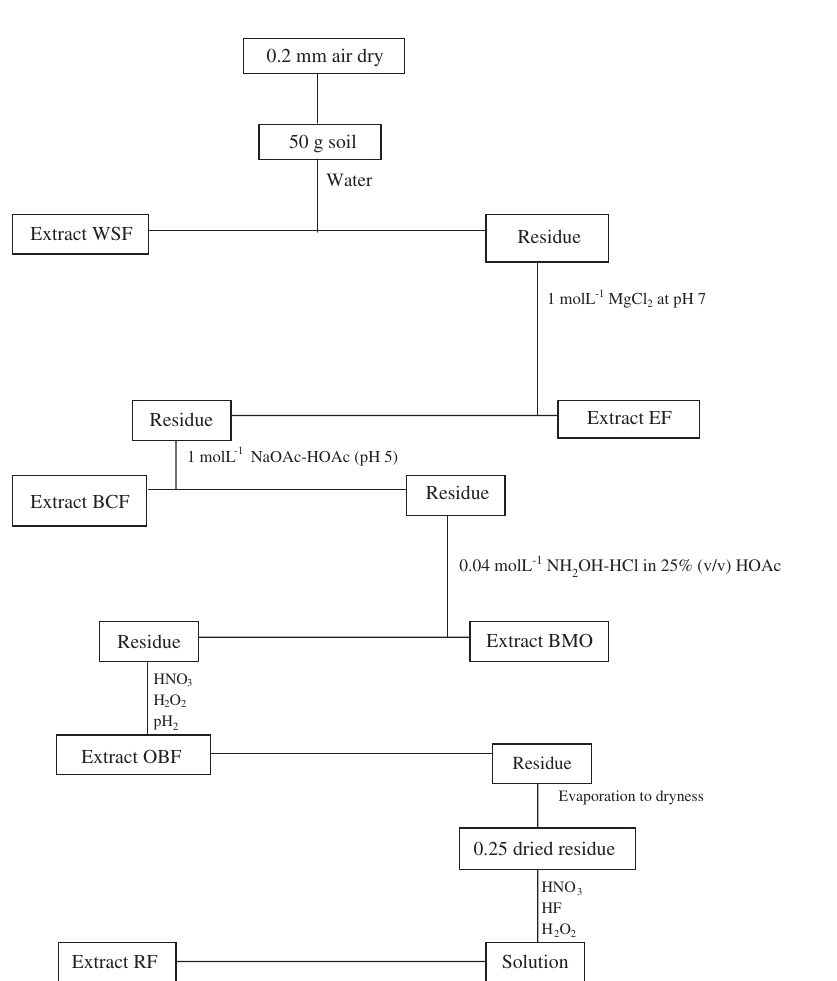
Figure 5: Flow diagram for the fractionation of metals in contaminated soils (Uduma and Jimoh, 2013).